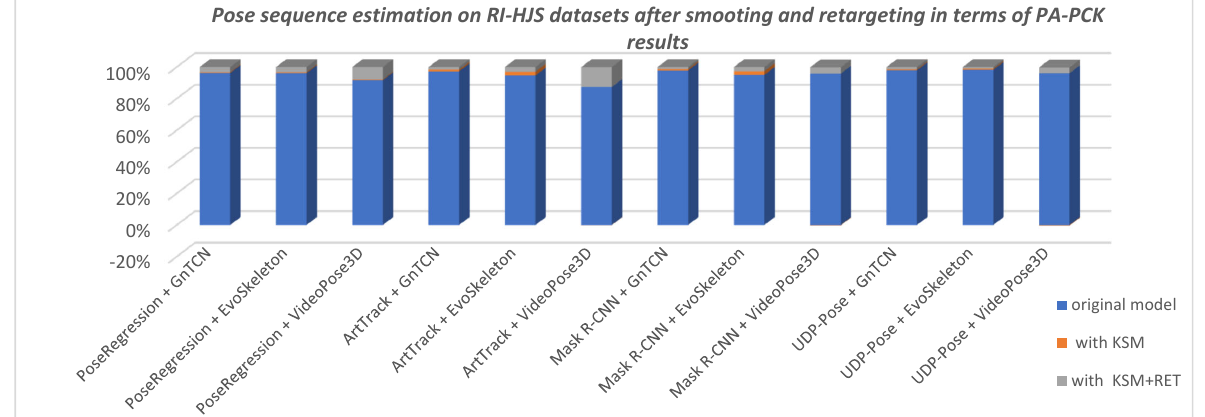
Figure 16. Comparison of pose sequence estimation in terms of PA-PCK on custom RI-HJS datasets (higher score is better). Two-step models that use EvoSkeleton show a significant improvement when using smoothing on the sequence of poses, showing the lack of consistency in the process of “lifting” 2D keypoints to 3D space. When using retargeting on the ground truth and smoothed pre ‐ dicted sequence, the results are significantly improved, indicating that all models lack an under ‐ standing of the human skeleton structure, which is especially true in the case of VideoPose3D.